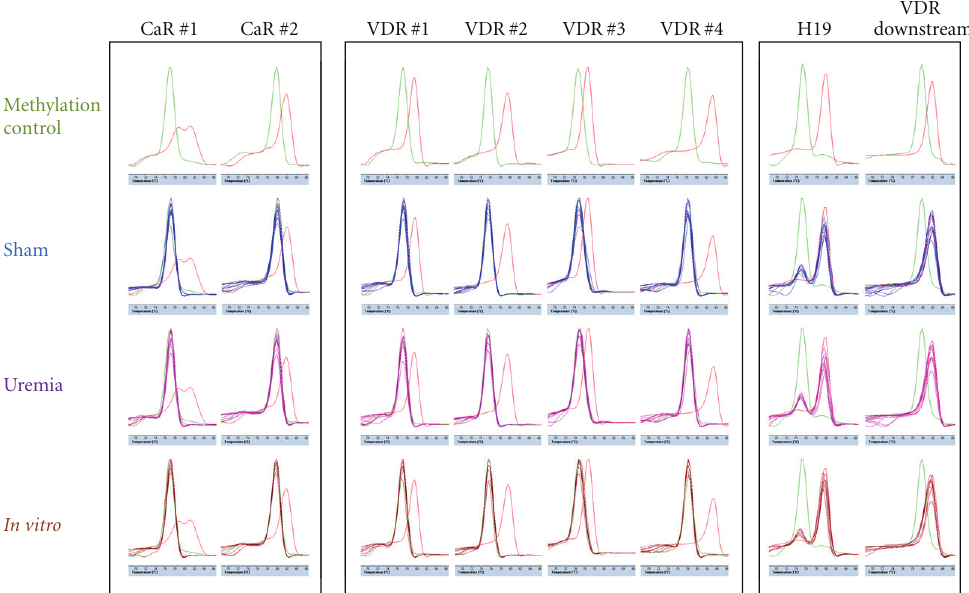
Figure 3: Methylation detection of CaR and VDR promoter regions in parathyroid glands. Analysis of the CaR and VDR promoter regions by PCR melting curve analysis after bisulfite treatment of genomic DNA. CaR is covered by PCR products CaR #1-2, and VDR is covered by PCR products VDR #1–4. Commercial low- and high-methylated rat DNA is analyzed in all of the PCR reactions shown in the “Methylation control” panel in green and red, respectively; it is also included in the “Sham,” “Uremia,” and “ in vitro ” panels. Control of methylation detection verified high levels of methylation in H19 and VDR downstream gene